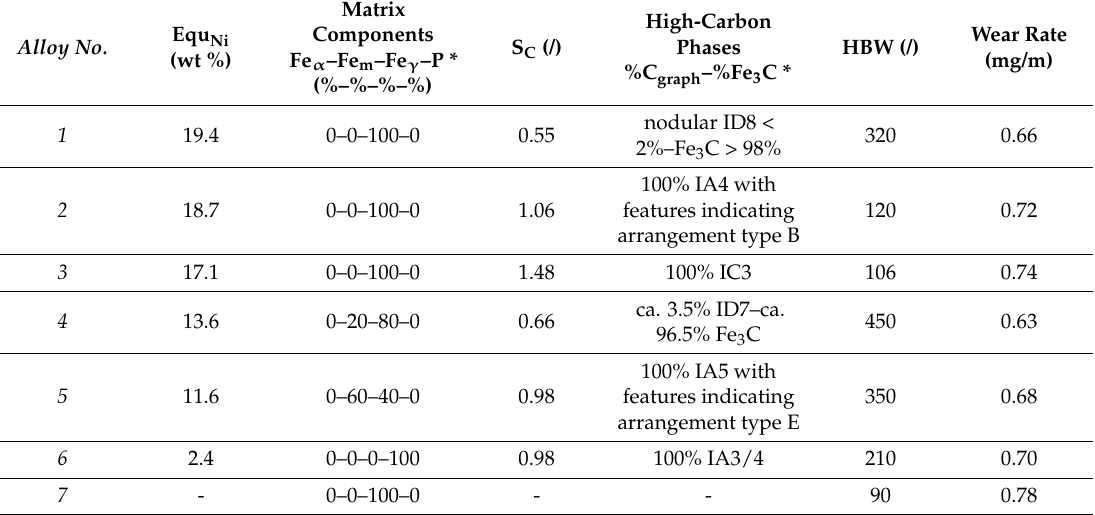
Table 2. Effect of nickel equivalent Equ Ni and eutectic saturation degree S C on structure composition, Brinell hardness and abrasive wear rate of castings.